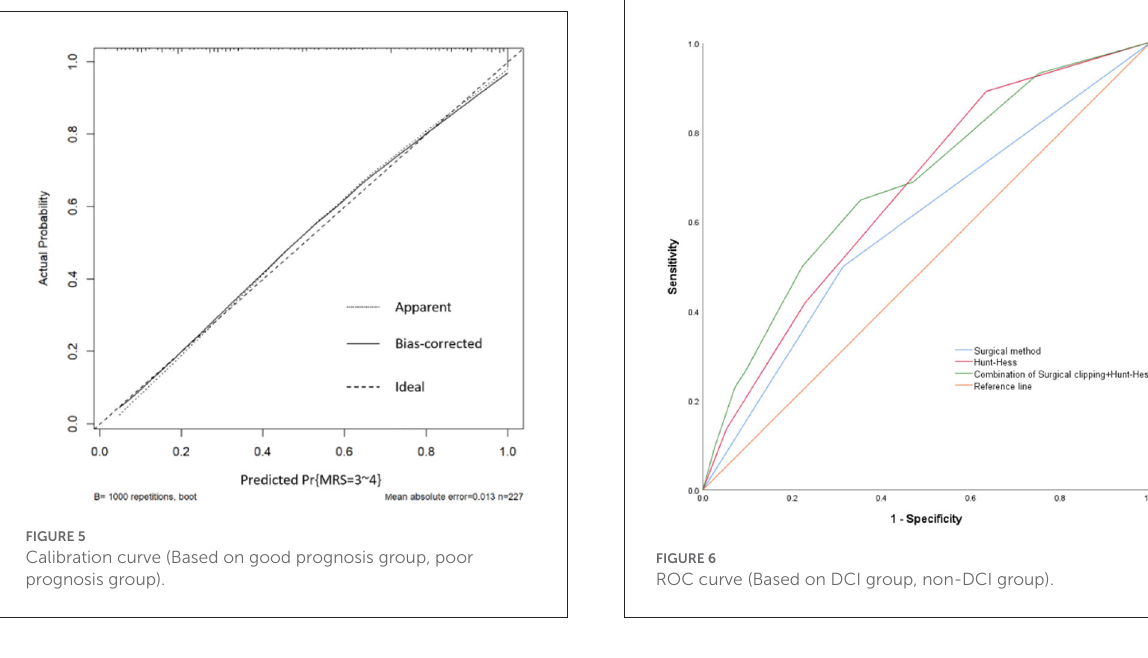
TABLE 5 The AUC, cut-off value, sensitivity, specificity from the ROC curve (Based on DCI group, non-DCI group).